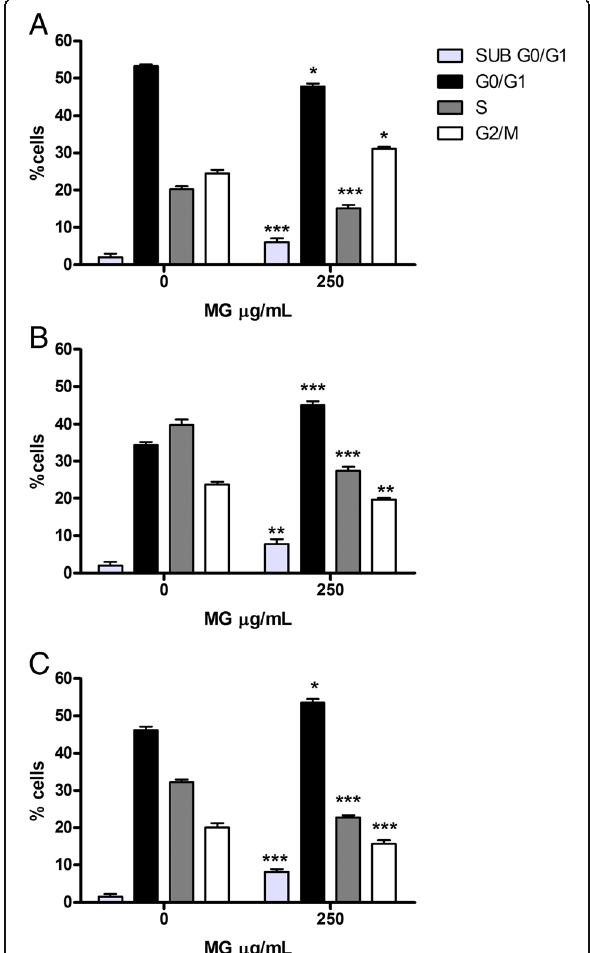
Fig. 6 Cell-cycle analysis of HL-60 cells treated with MG extract. Fraction of HL-60 cells in the different phases of the cell-cycle after MG treatment for 24 h ( a ) 48 h ( b ) and 72 h ( c ) was evaluated as reported in Materials and Methods section. Each bar represents the mean ± SEM of five independent experiments. Data were analysed using repeated ANOVA followed by Bonferroni post-test. * p < 0.05 vs control; ** p < 0.01 vs control; *** p < 0.001 vs